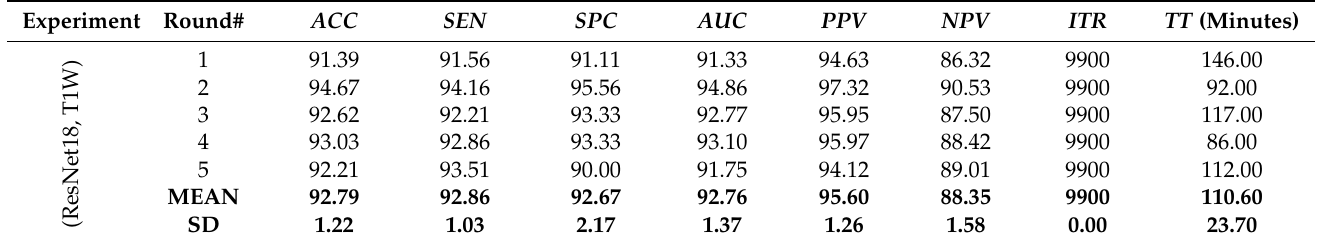
Table A5. Test results of five-folds of experiment (ResNet18, T1W).